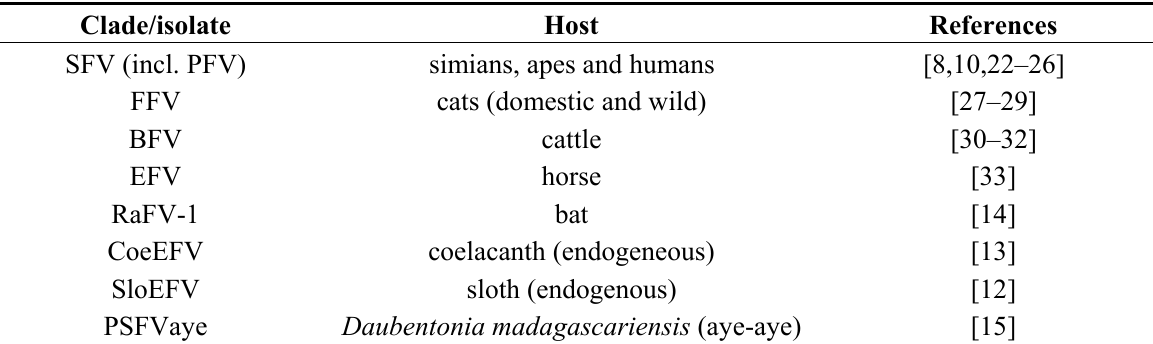
Table 1. Foamy virus clades/isolates and their